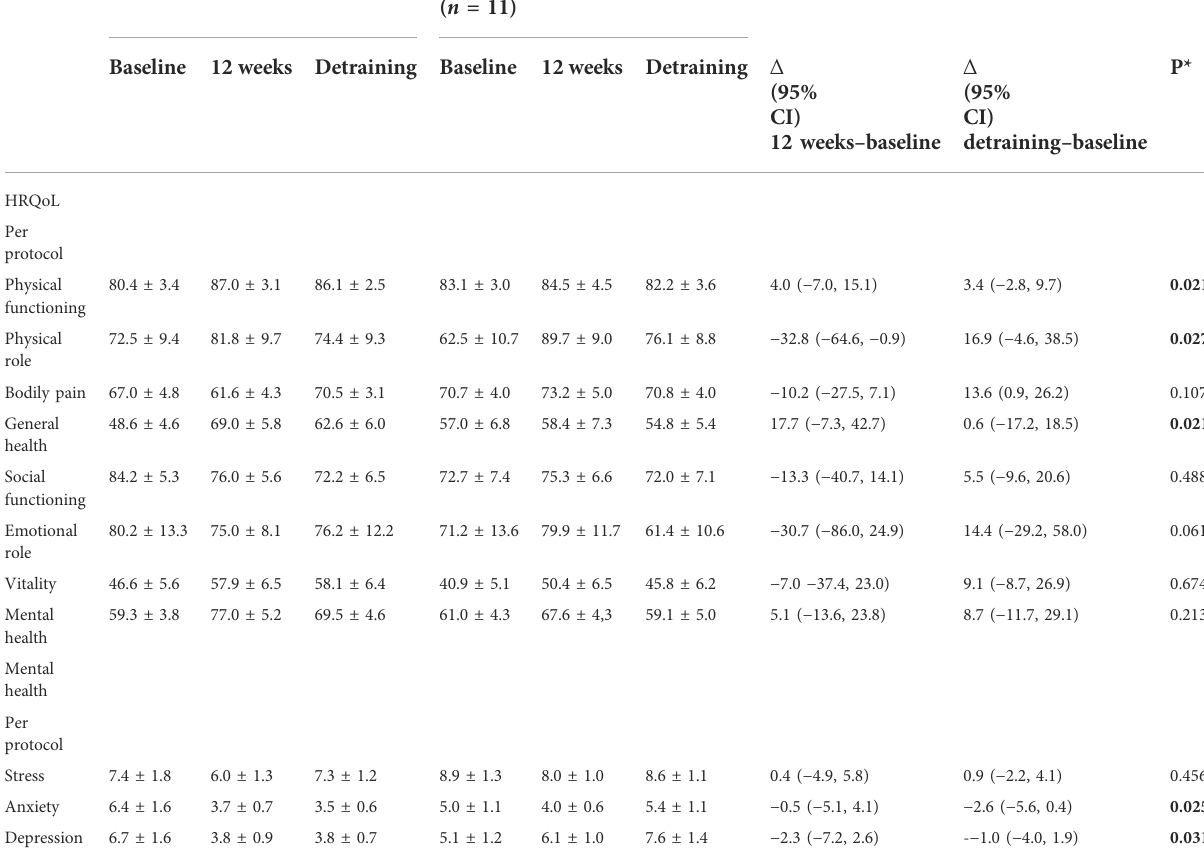
TABLE 3 Health-related quality of life (HRQoL) and mental health of women with PCOS at baseline, after 12 weeks of HIIT and after 4 weeks of detraining. HIIT group per protocol ( n = 12) Control group per